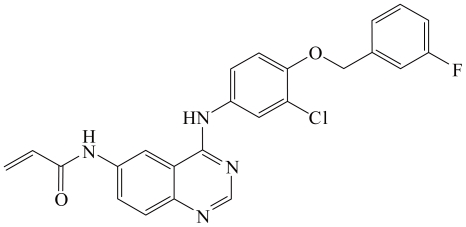
Chemical structure of AST1306.